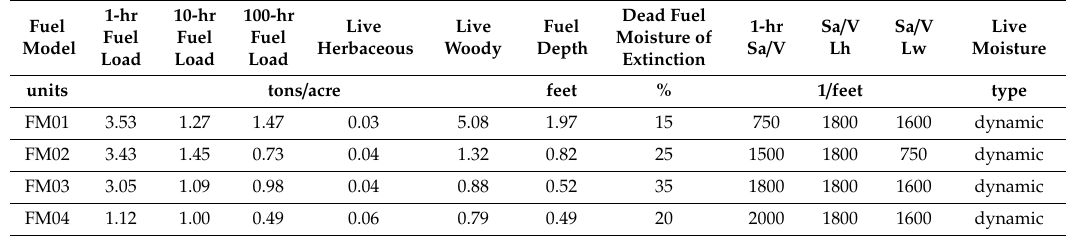
Table A1. Parameters of the custom fuel models used in Lesvos simulations. Table adapted from [47]. Sa / V: fuel surface area-to-volume ratio; Lh: Live herbaceous; Lw: Live